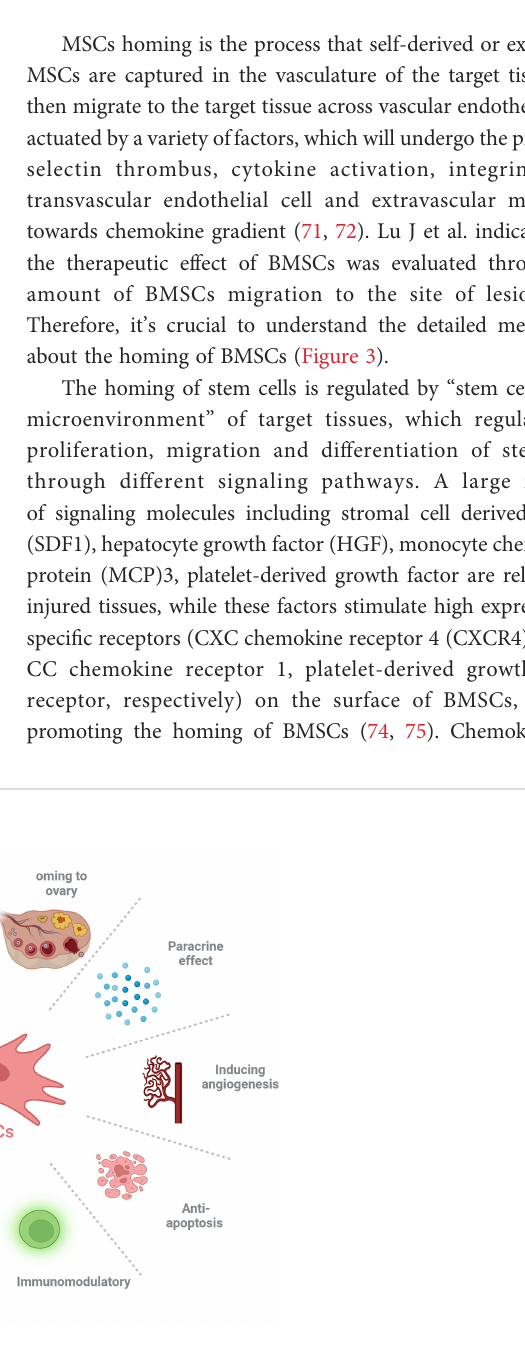
FIGURE 2 The possible mechanisms of bone marrow-derived mesenchymal stem cells (BMSCs) ameliorate premature ovarian failure (POF). BMSCs ameliorate ovarian function of POF through homing to injured ovary, paracrine effect, inducing angiogenesis, anti-apoptosis, anti-in fl ammatory, immunoregulation, autophagy regulation, anti fi brosis, anti-oxidative stress and mitochondrial